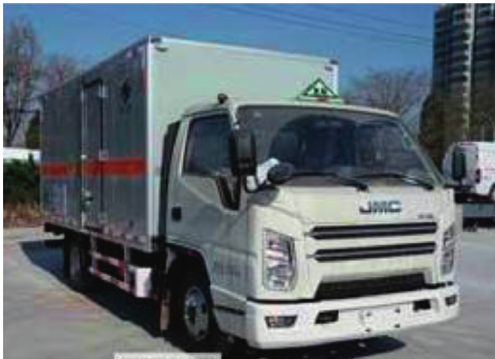
Figure 6: HYJ5060XFS-JX radioactive material